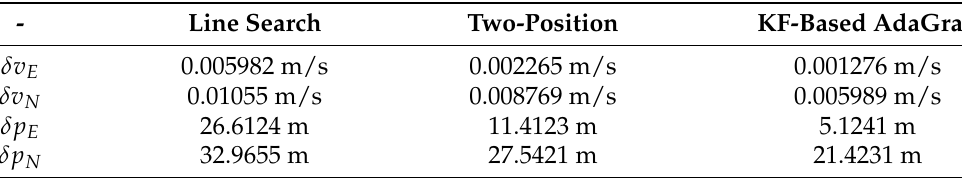
Table 5. RMS of velocity and position errors.